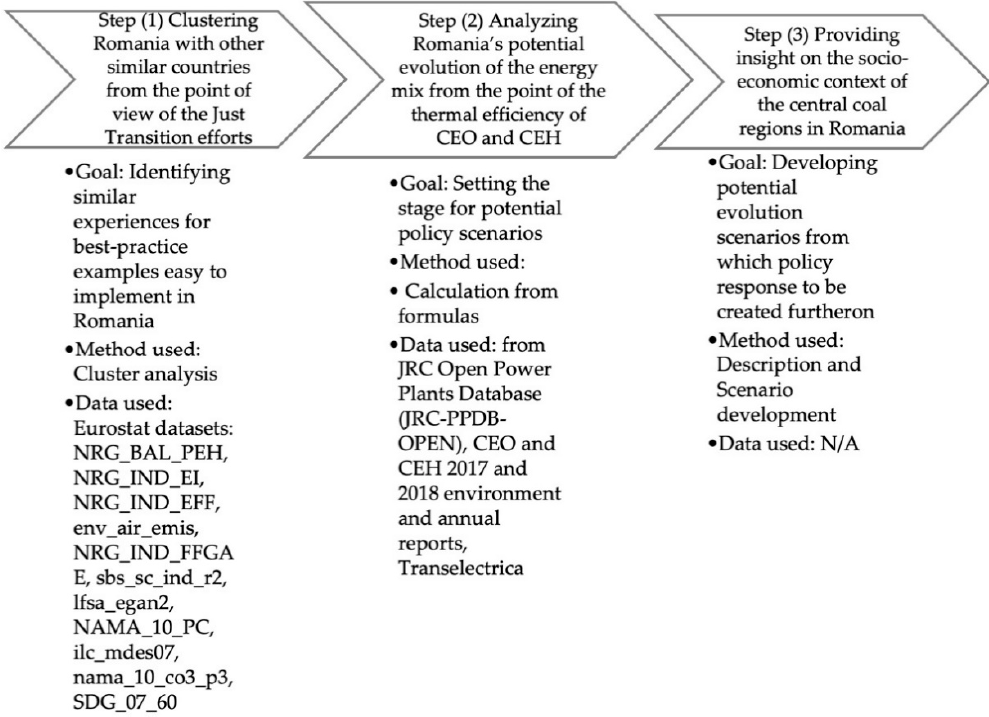
Figure 1. Methodological framework for the analysis—steps.